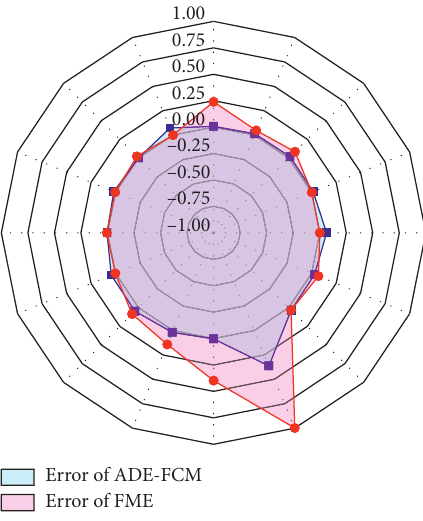
Figure 7: Comparison of estimation